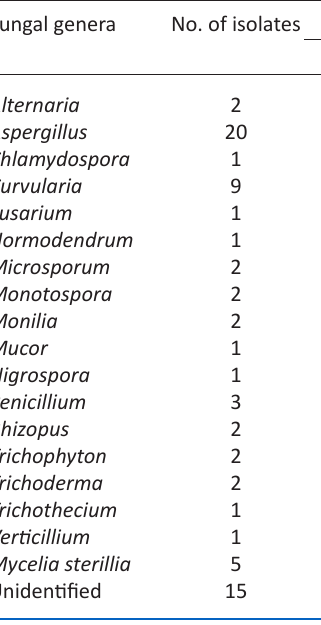
± indicates SD of three replicates